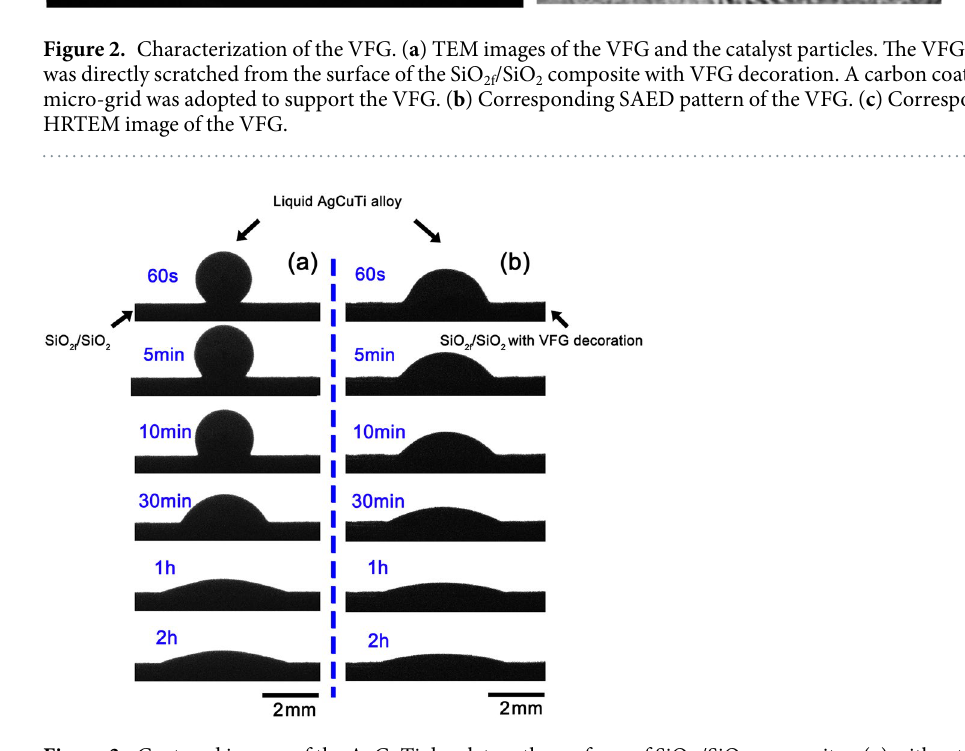
Figure 3. Captured images of the AgCuTi droplet on the surfaces of SiO 2f /SiO 2 composites: ( a ) without VFG decoration and ( b ) with VFG